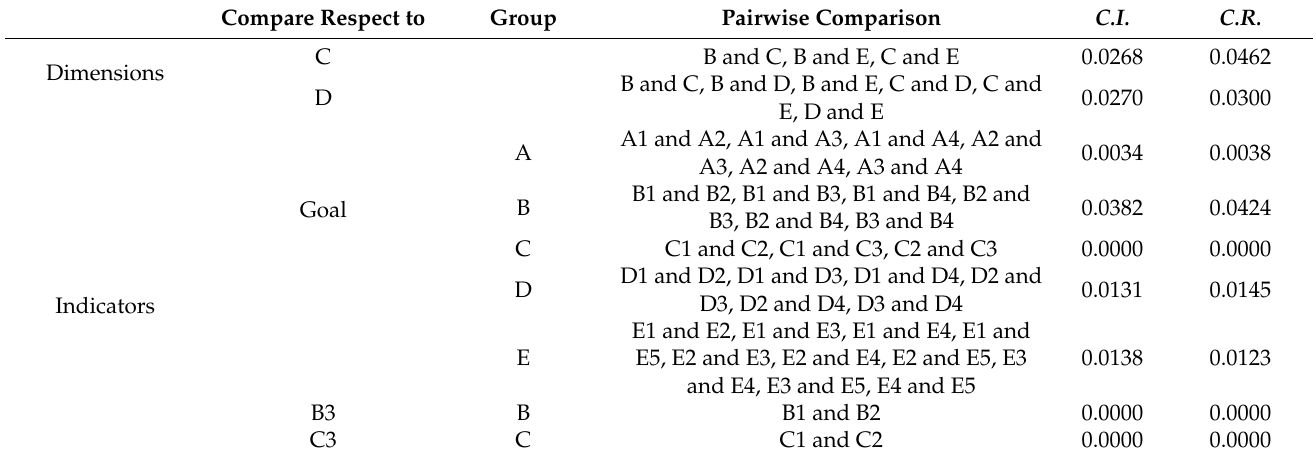
Table 10. C.I. and C.R values for other dimensions and indicators.